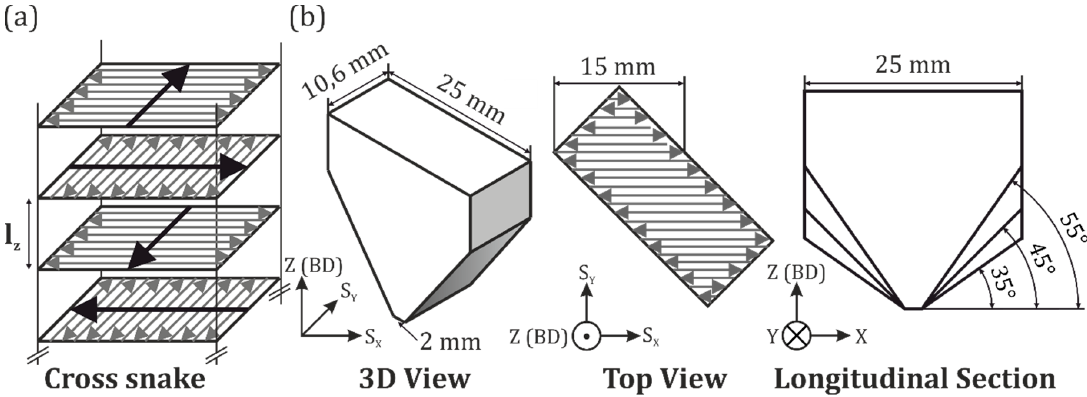
Figure 1. ( a ) Schematic of the cross snake scan strategy used; ( b ) Schematic of the trapezoidal prism geometry used in the present study. The build direction (BD) Z and the scan vectors S X and S Y are indicated. Note the rotation of the sample coordinates X and Y in the longitudinal sections by 45° with respect to S X and S Y .